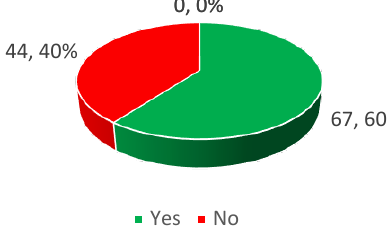
Figure 6. Does your pet have a favorite place to sleep?